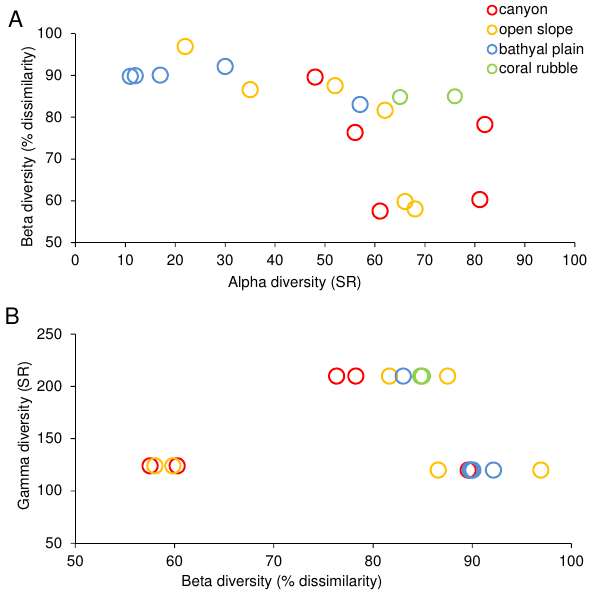
Fig. 5. Relation between: (A) α diversity and β diversity; and (B) β diversity and γ diversity, across the habitats (as indicated) of the deep-sea Mediterranean sites investigated.